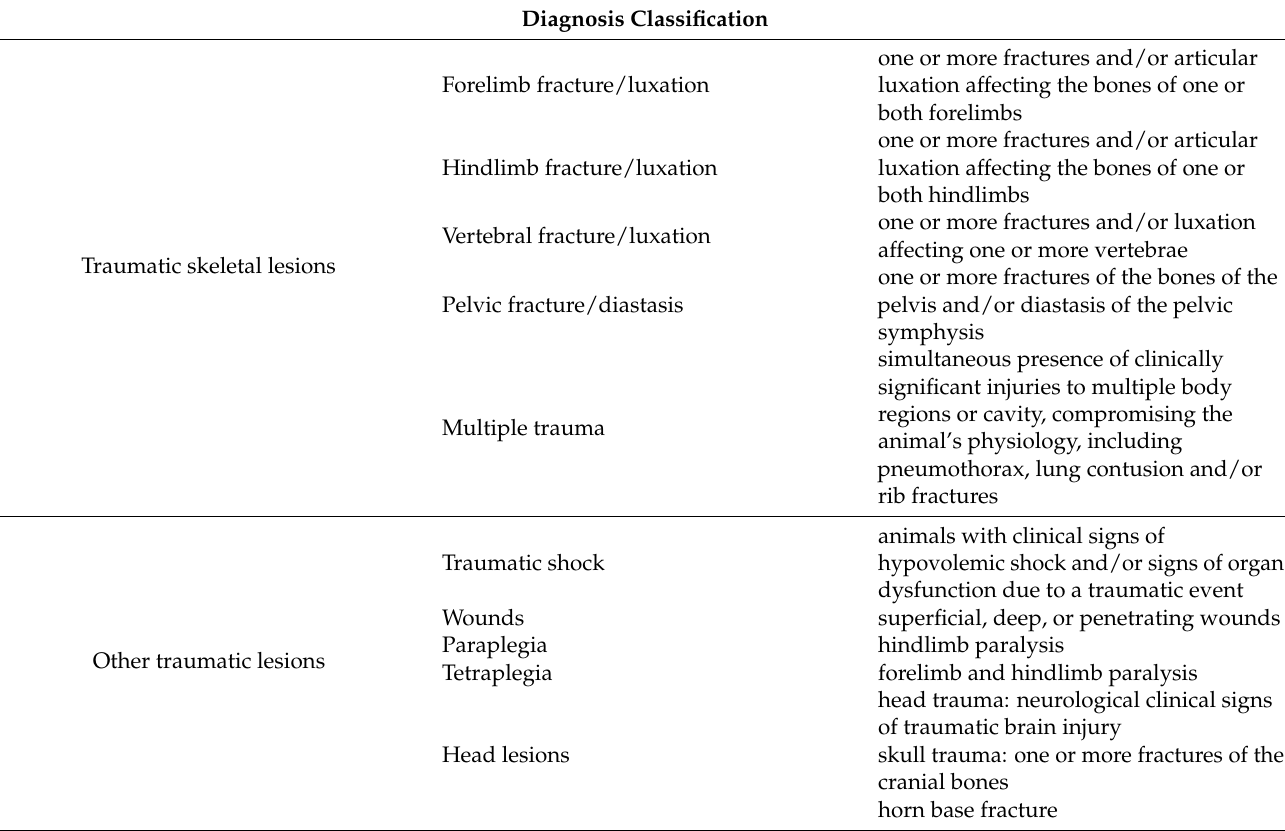
Table 2. Categories for clinical diagnosis classification. Diagnosis